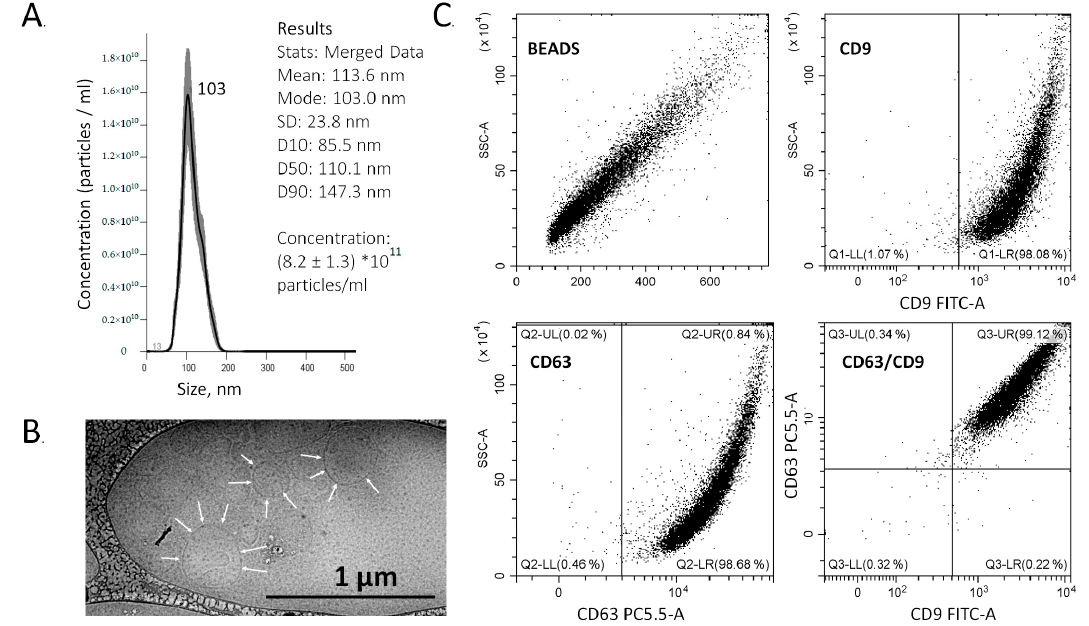
Figure 1. Characteristics of plasma ENV isolated by PTPS. ( A ) Evaluation of the size and concentration of ENVs using nanoparticle tracking analysis (NTA). ( B ) Morphology of particles imaged by Cryo-EM. Vesicular membranes are indicated by arrows. ( C ) Analysis of the expression of exosomal markers CD63 and CD9 on the vesicle membrane. Vesicles were nonspecifically bound onto the latex beads. After incubation with fluorescently labeled antibodies (CD9 or CD63), fluorescence intensities were determined for the corresponding channels (FITC and PC5.5). The lower right square is the result of combining the data from two channels and indicates that 99.1% of particles with fixed ENVs bind both antibodies, i.e., almost all vesicles are positive for both exosomal markers.